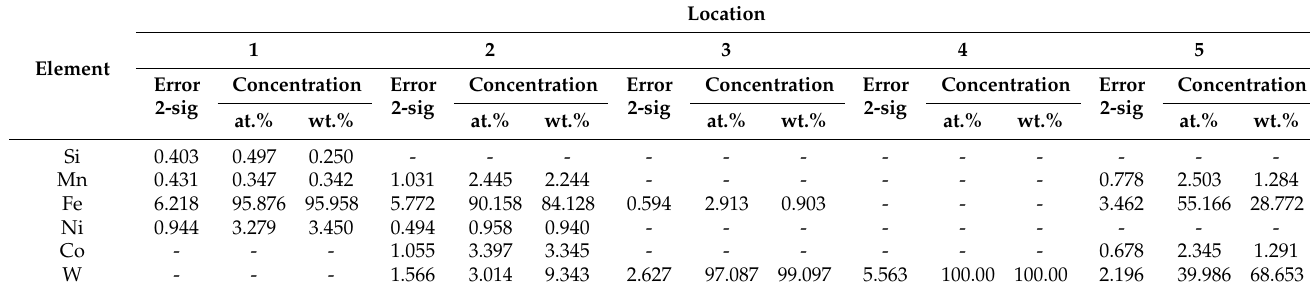
Table 3. Elemental composition of the material at the various locations of the tooth according to Figure